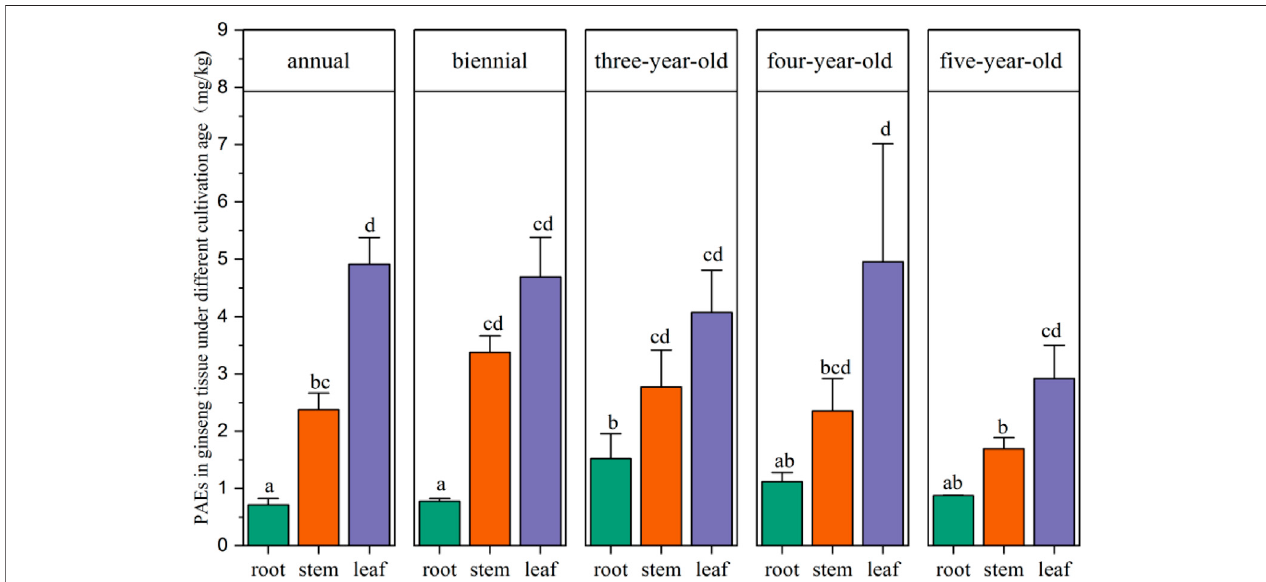
Figure 4B indicate that the concentrations of DMP, DEP, DPrP, DIBP, DBP, DHXP, and DEHP in ginseng leaves were higher